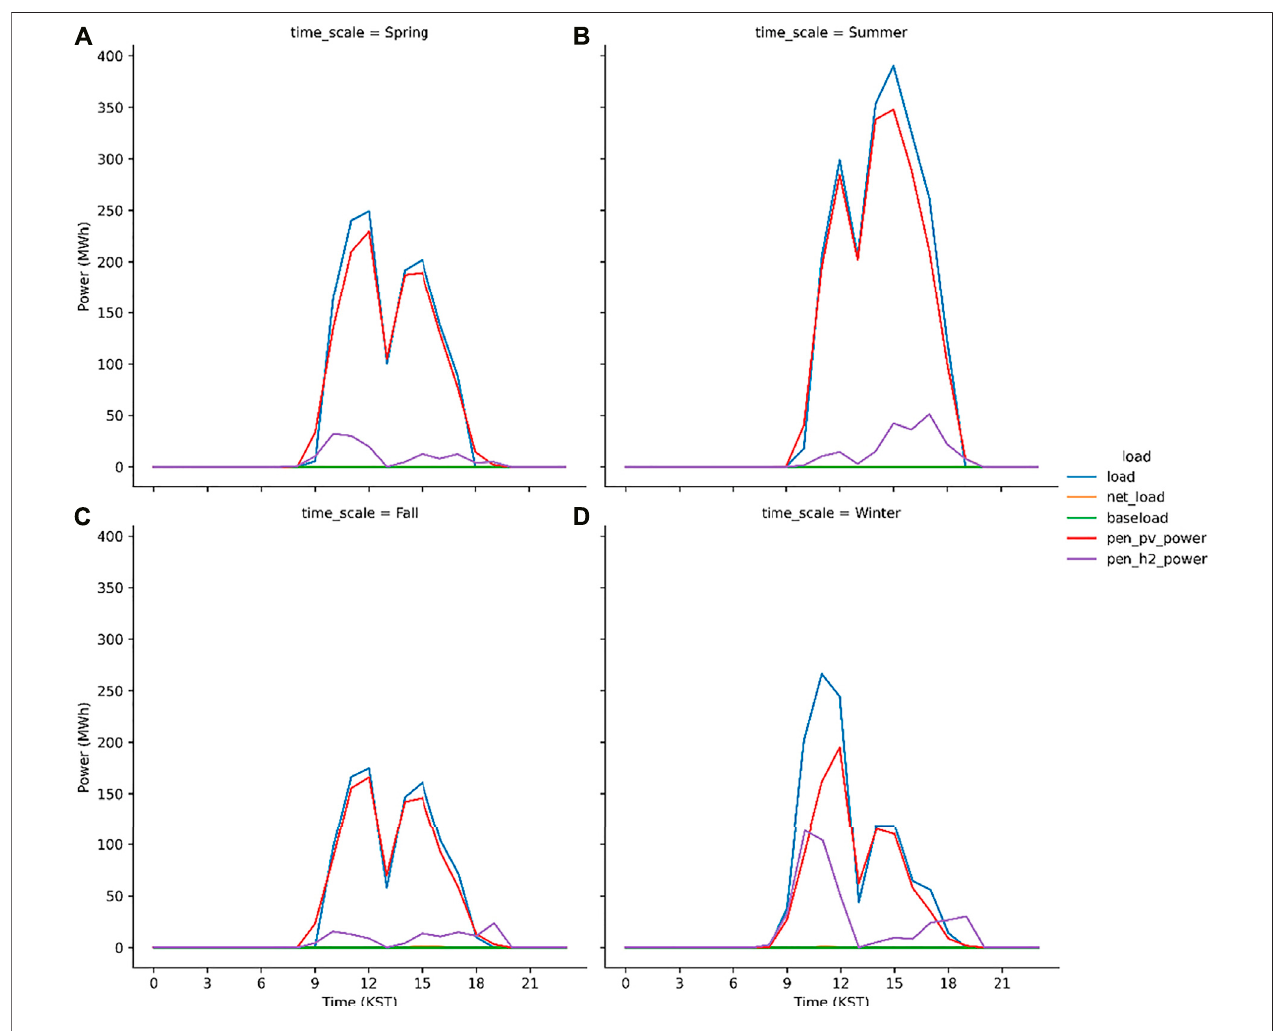
FIGURE 9 | Same as Figure 8 but for spring (A) , summer (B) , fall (C) and winter (D) .